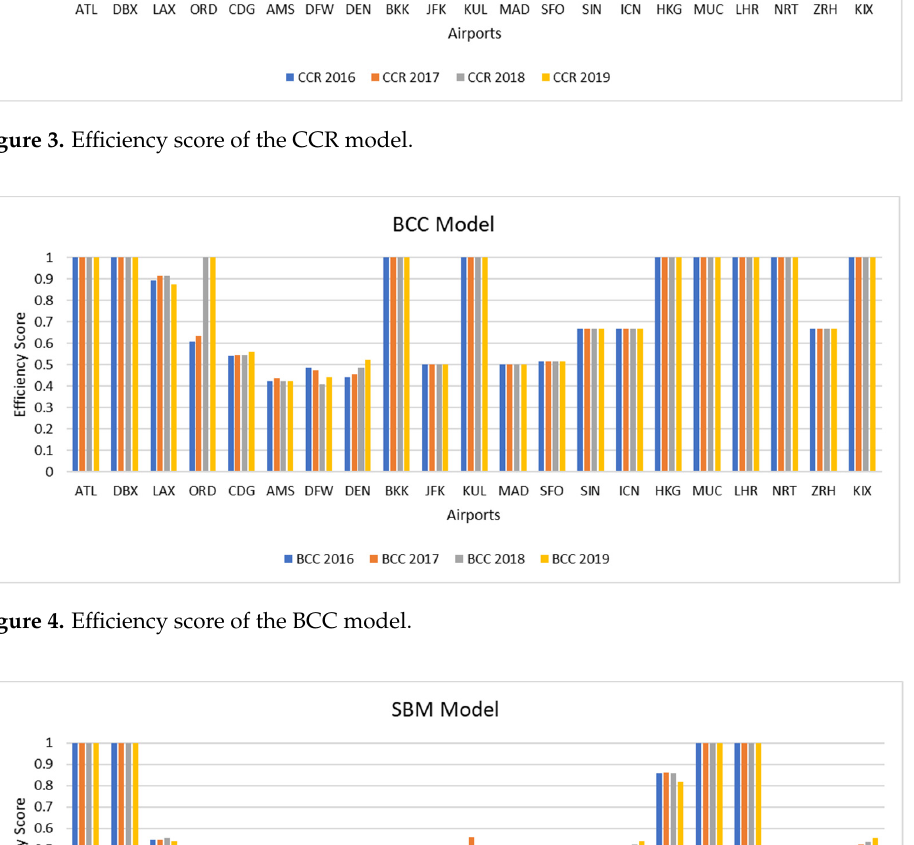
Figure 5. Efficiency score of the SBM model.